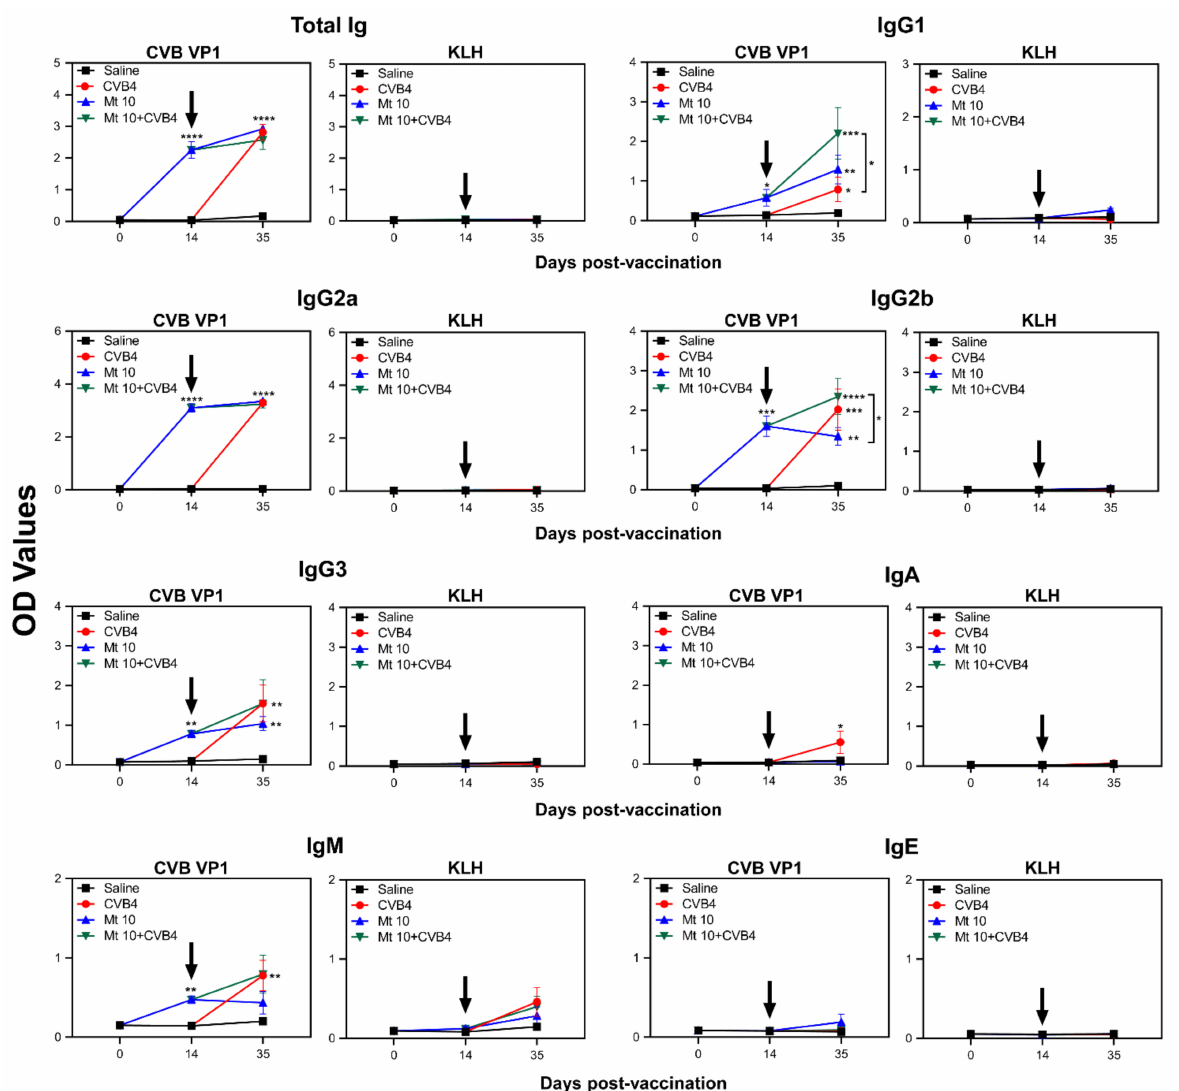
Figure 3. Vaccinated mice induce VP1-specific nABs. Serum samples collected from the indicated groups at various time points were diluted (1:150) and added in duplicates to high-binding plates previously coated with CVB3-VP1 or KLH (control). After adding HRP-conjugated goat anti-mouse total Ig, IgG1, IgG2a, IgG2b, IgG3, IgA, IgM, and IgE as detection antibodies, reactions were stopped. Plates were read at 450 nm to obtain the OD values. Mean ± SEM values obtained from n = 6 samples, each representing 3 to 5 mice, are shown. Two-way ANOVA and Mann–Whitney test were used to determine significance between groups. * p ≤ 0.05, ** p ≤ 0.01, *** p ≤ 0.001, and **** p ≤